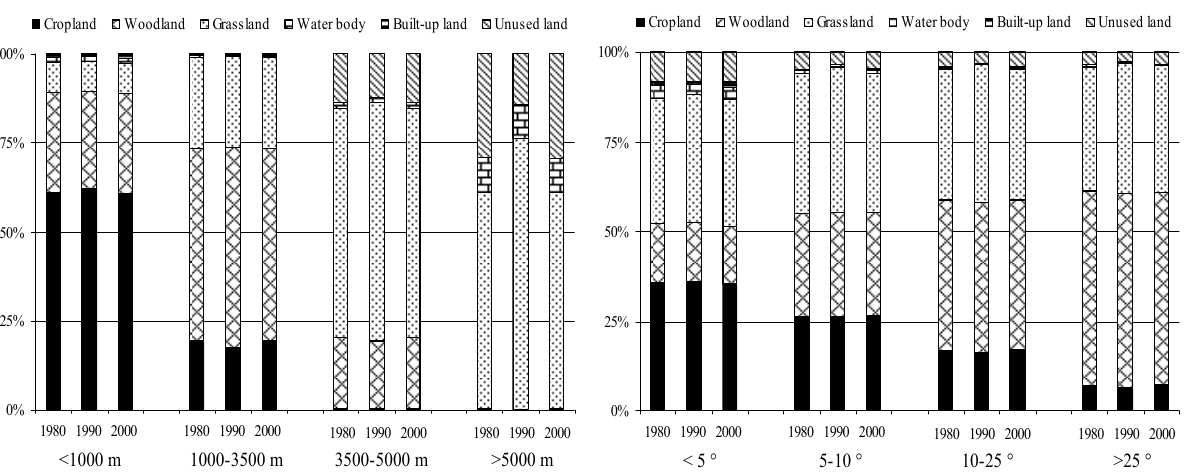
Figure 4. Land use/cover percentages in different elevation (left) and slope (right) ranges from 1980 to 2000. (Three columns in each elevation and slope range stand for the data of 1980, 1990 and 2000 from left to